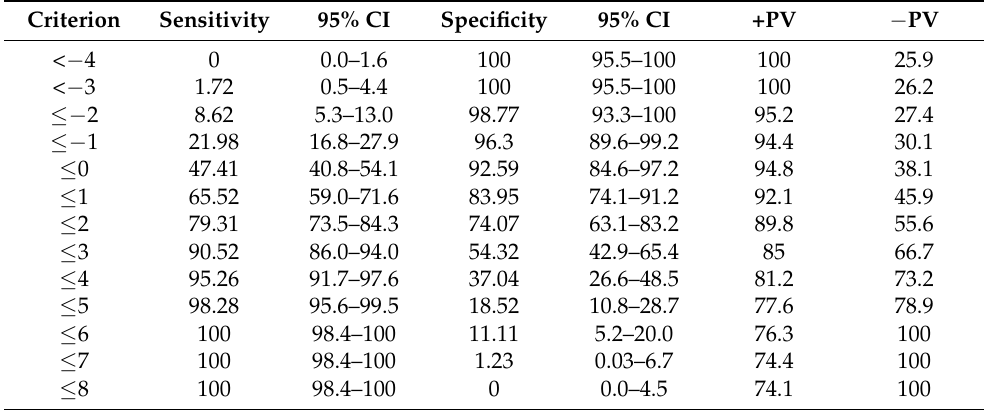
Table 5. Sensitivity, specificity, predictive positive, and negative values of GOL2DS score in predicting ICU